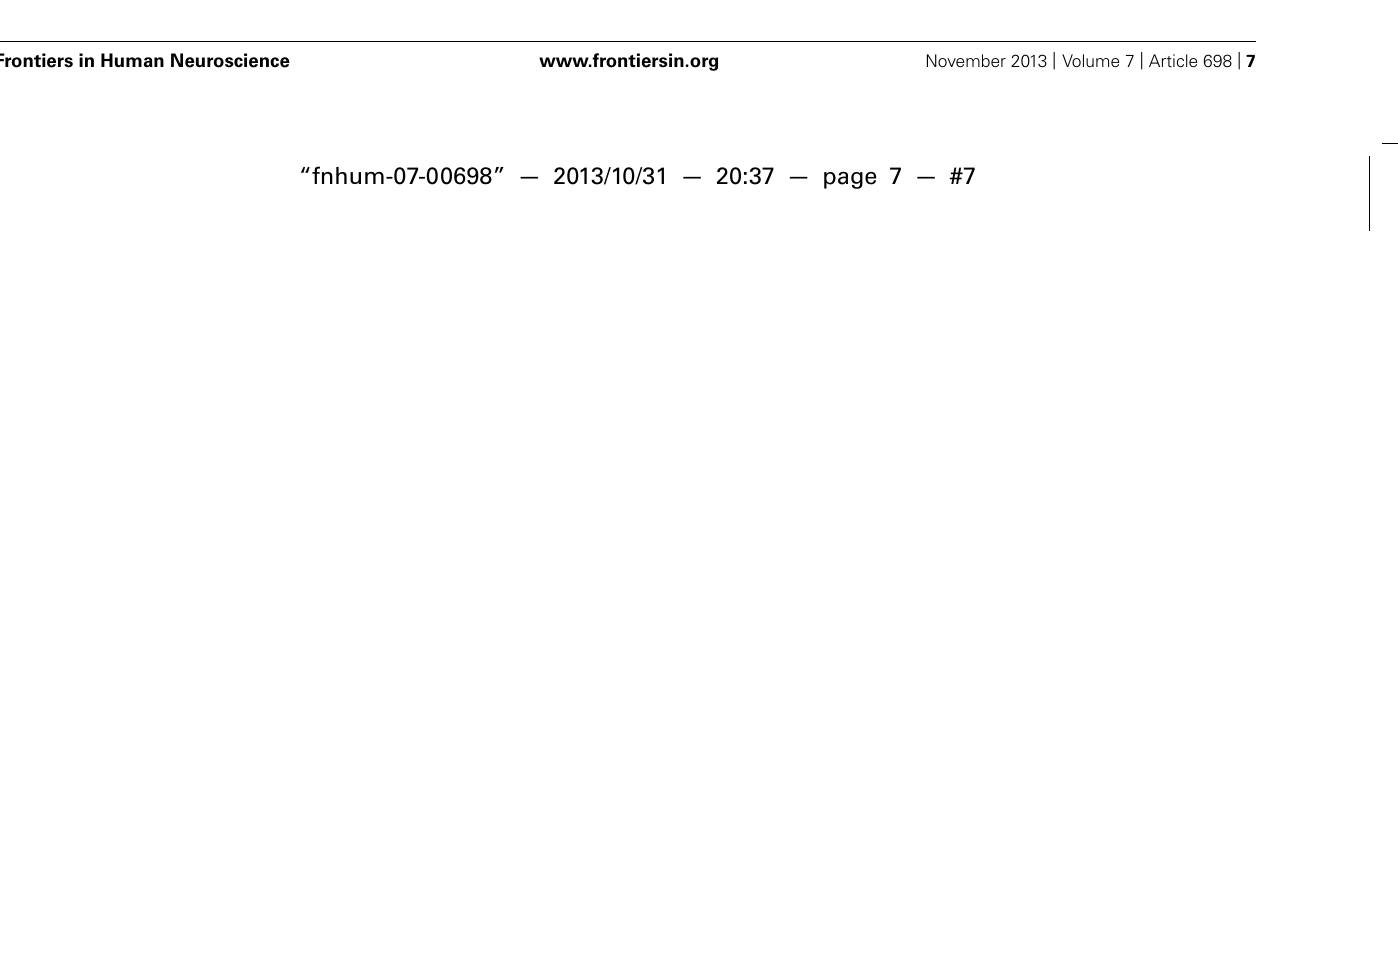
body posture was consistent with that of the avatar, in the visual condition, there was no such trend. Error bars show within-subjects standard error of the mean.